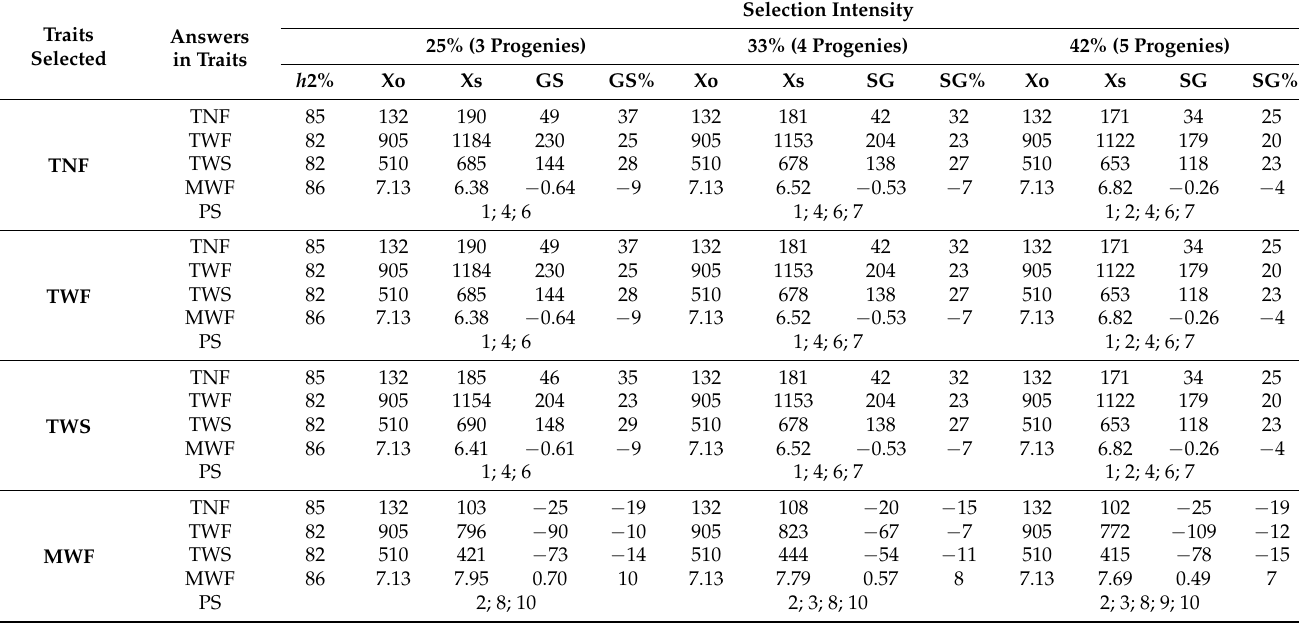
Xo—initial population average. Xs—average of the selected population. h 2—broad-sense heritability. SG—selection gains; PS—progenies selected: 1—Dos de Mayo; 2—Shanao; 3—S ã o Pedro; 4—Cuzco;